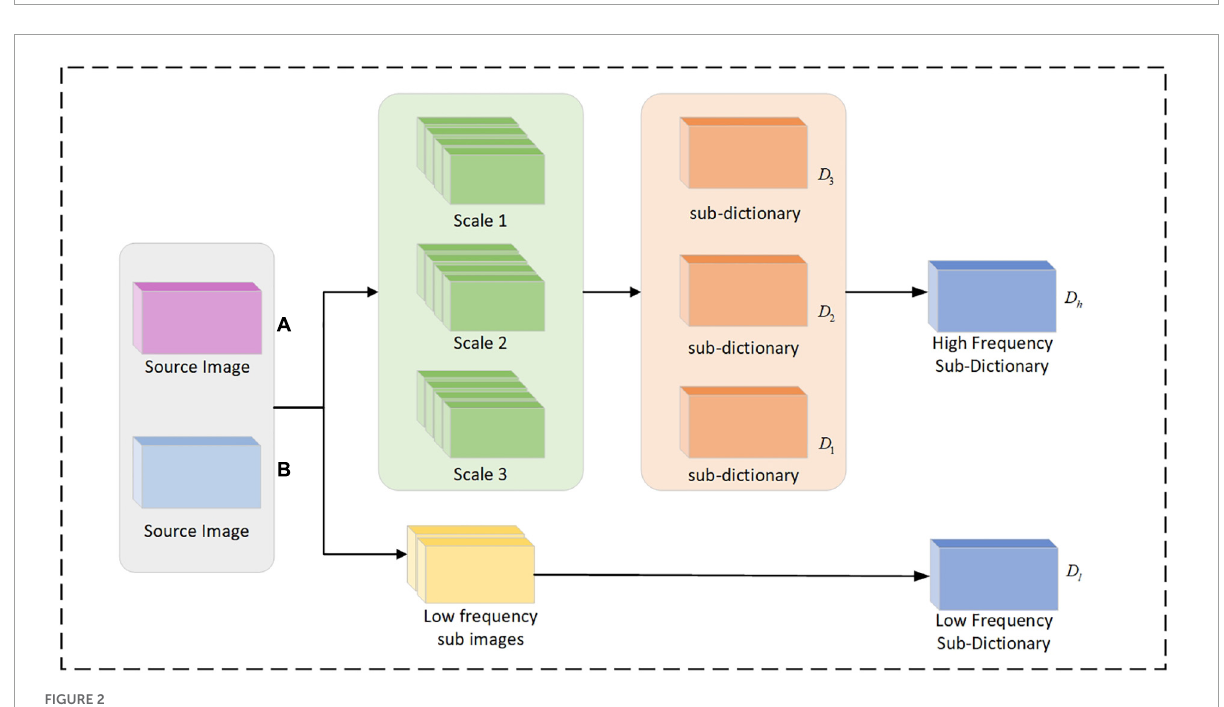
FIGURE2 Flow chart of multi-scale dictionary